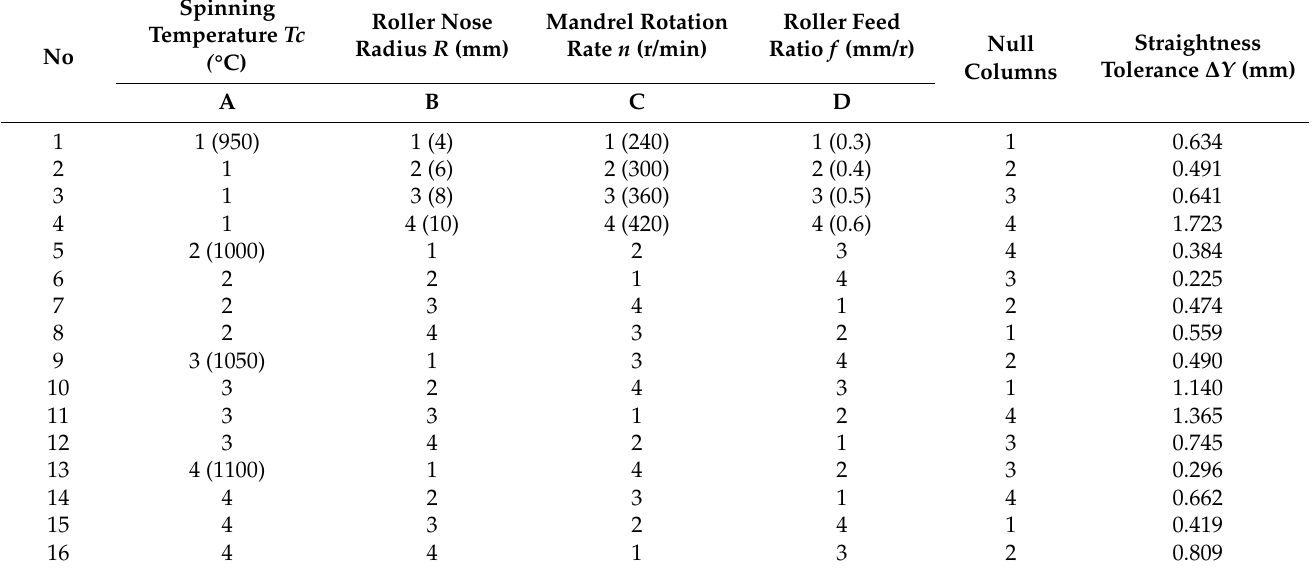
Table 5. Orthogonal experimental design and